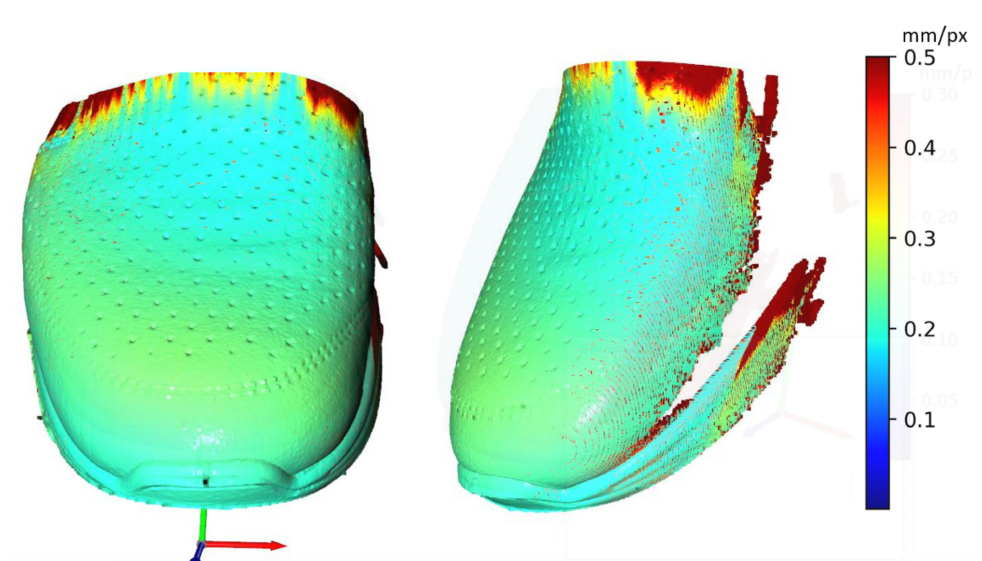
Figure 16. Displaying of resolution (Rx) in X-axis (SCAN 20).